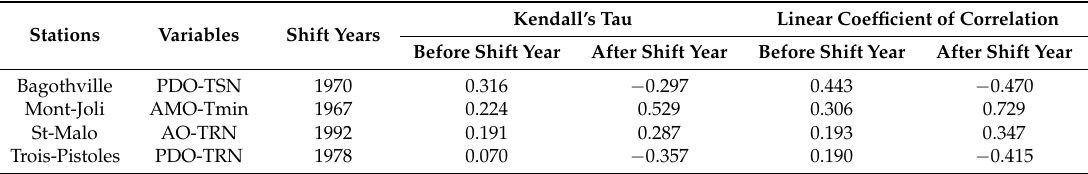
Table 9. Comparison of Kendall’s tau and coefficient of linear correlation values between climate indices and climate variables before and after shifts.